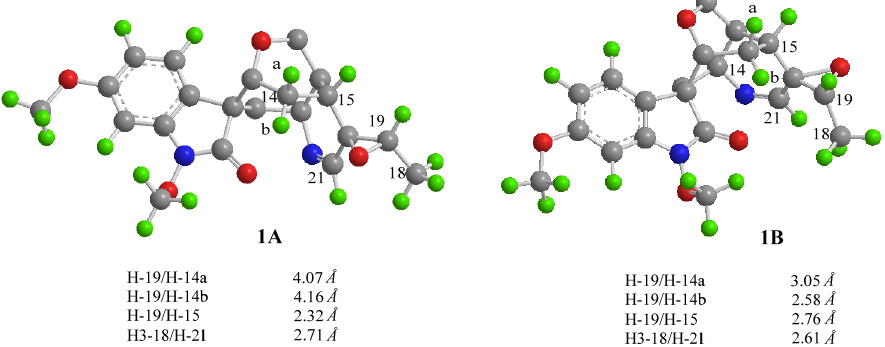
Figure 3. Calculated interproton distances near the epoxide for the two possible structures ( 1A and 1B ) of compound 1 .